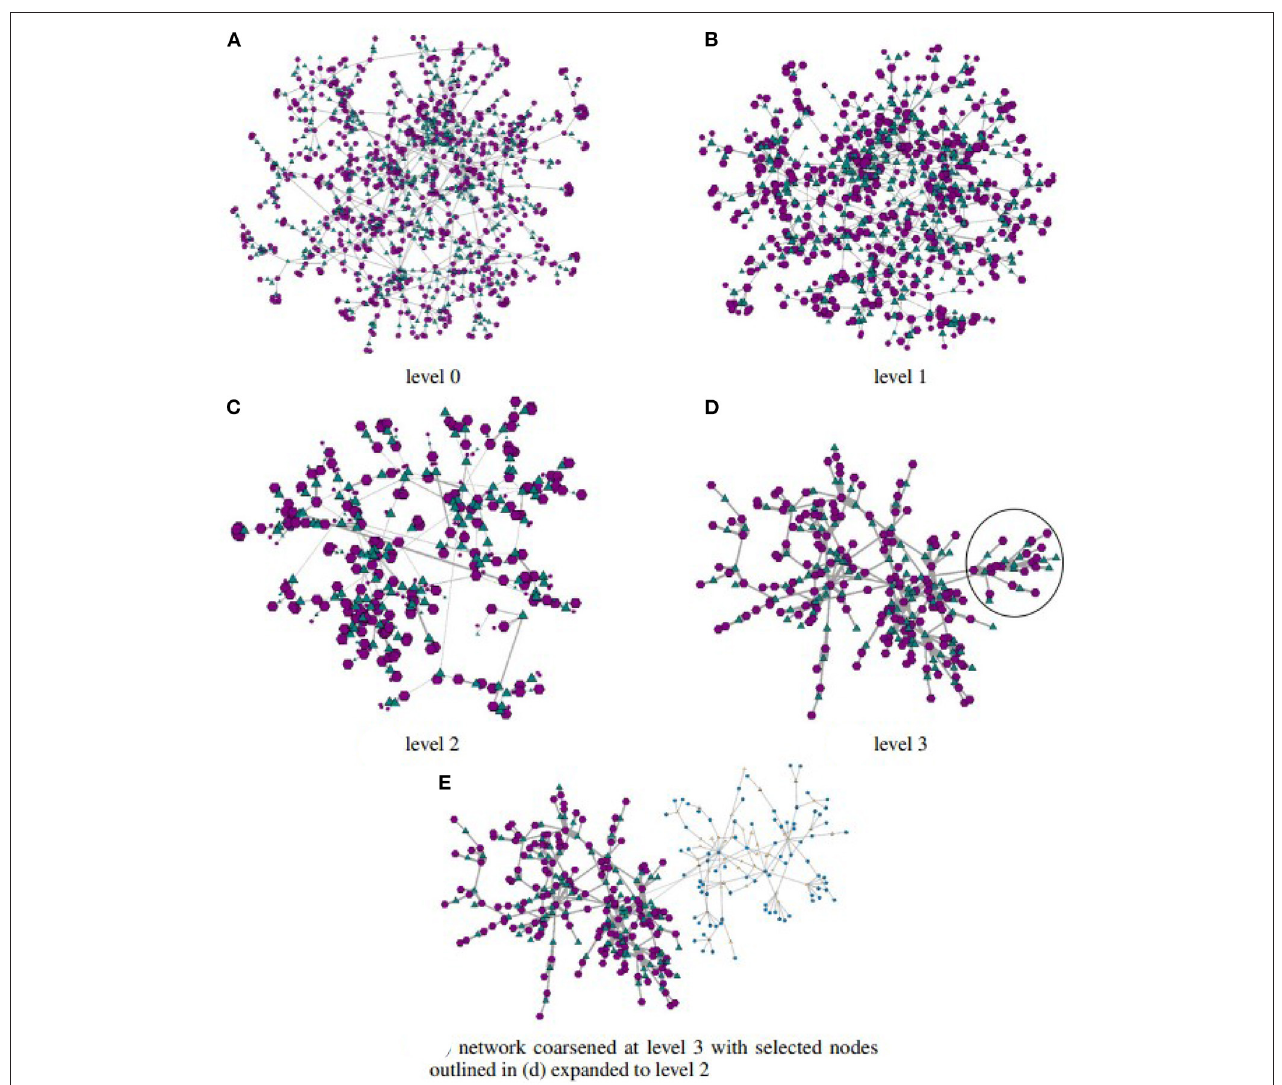
FIGURE 8 | Biological bipartite network depicting the relationships between 516 diseases (purple hexagons) and 903 genes (green triangles). Panel (A) shows the initial network, which is depicted at increasing levels of coarsening in (B) with | V 1 | = 323 and | V 2 | = 485 super-nodes and 866 super links, (C) with | V 1 | = 214 and | V 2 | = 273 super-nodes and 524 super-links, and in (D) with | V 1 | = 142 and | V 2 | = 161 super-nodes and 328 super-links; finally panel (E) shows the expansion back to level 2 of the elements within the black circle in (D) , detailing an interesting